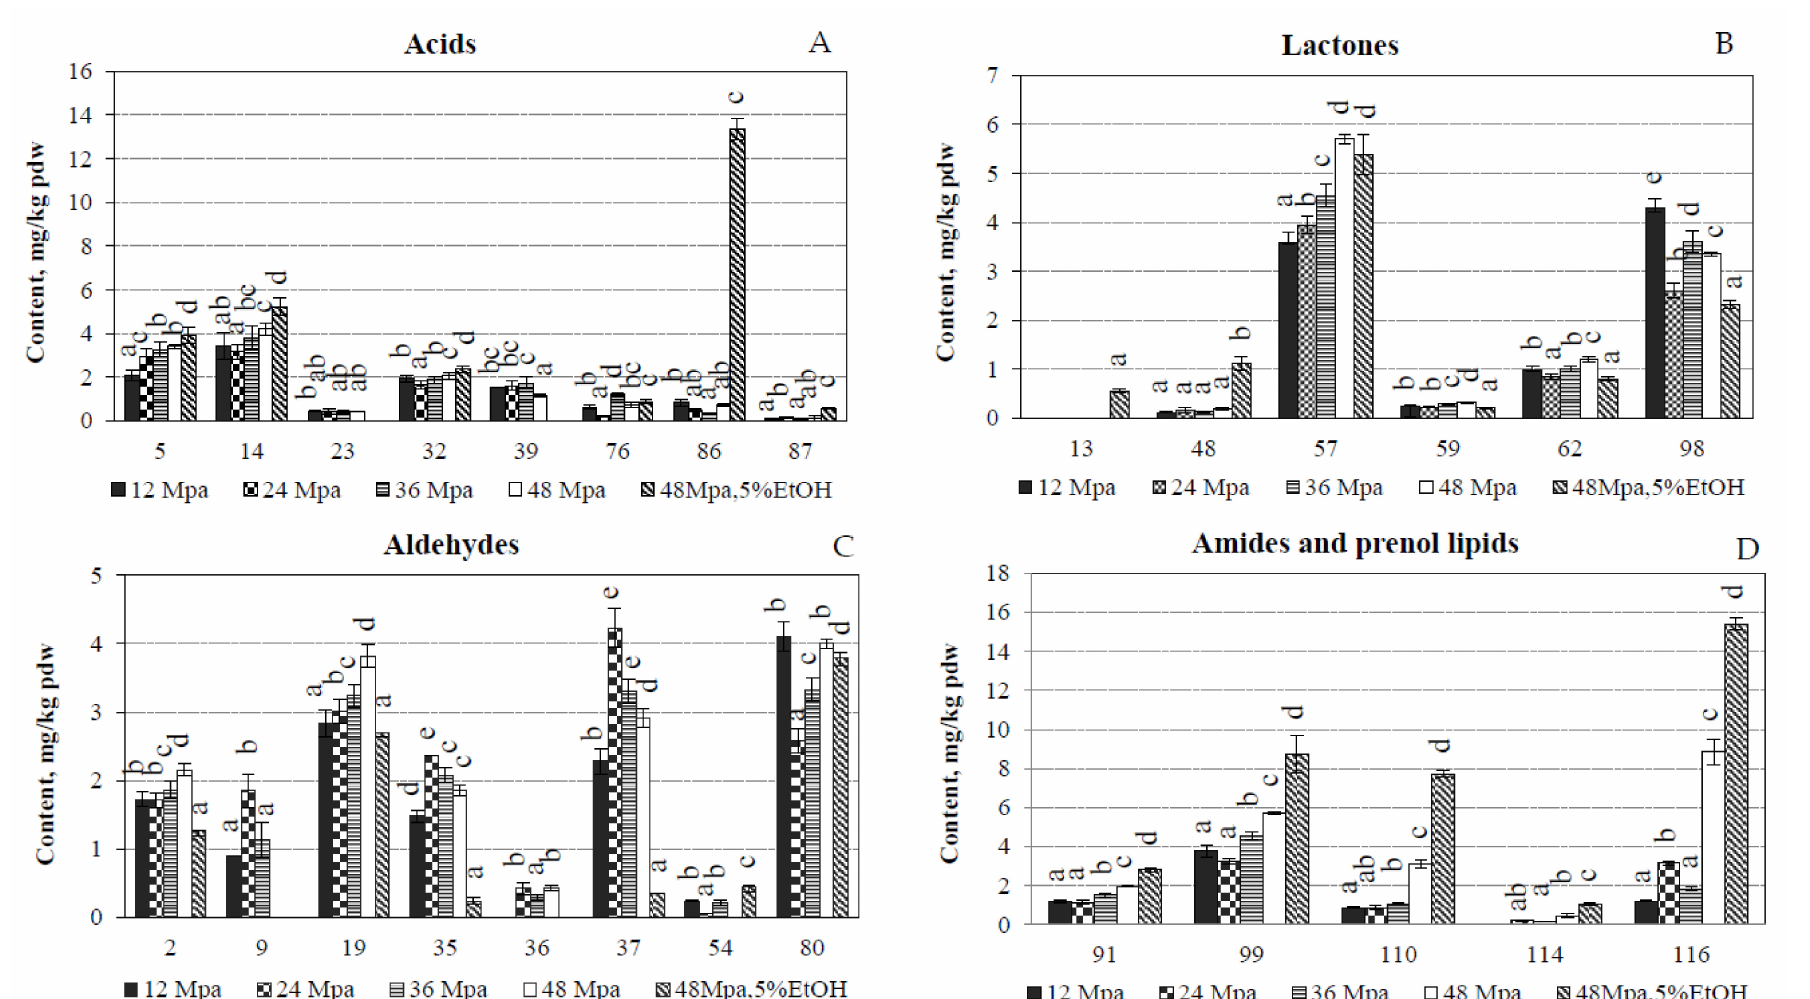
Figure 2. The absolute amounts of main volatile compounds of major classes (( A )—Acids, ( B )—Lactones, ( C )—Aldehydes, ( D )—Amides and prenol lipids) of Narcissus poeticus SFE-CO 2 extracts, in mg/kg pdw. Constituents are numbered by the same order as provided in Table 2. Values within columns followed by the same letter (a–e) do not differ statistically at p < 0.05 (Duncan